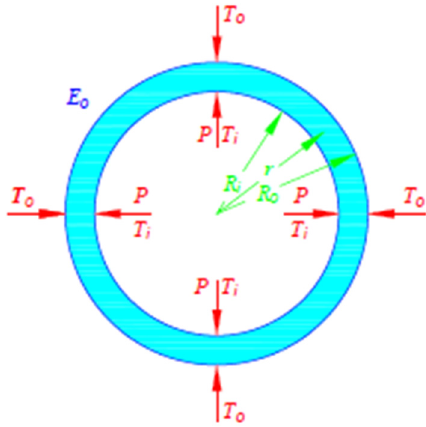
Figure 1. The cross-section of the functionally graded pressure vessel subjected to internal pressure and thermal loadings.